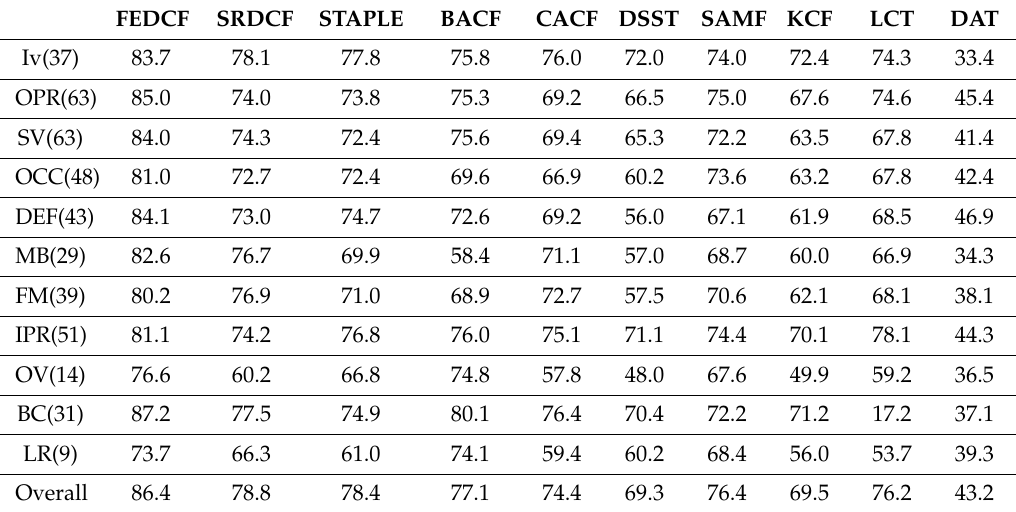
Table 3. The one-pass evaluation of FEDCF and compared trackers in term of PR score on OTB2015. The top three scores are highlighted in red, green and blue respectively.